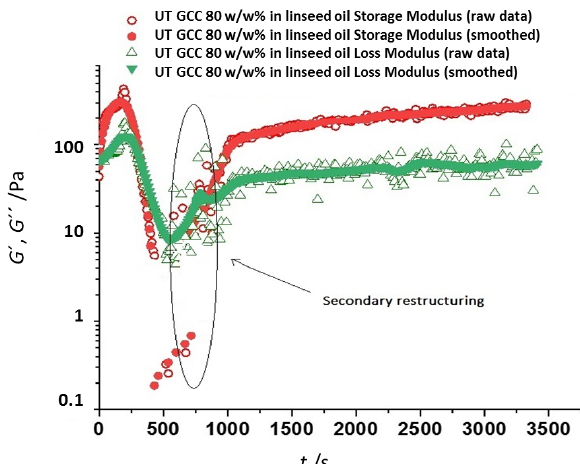
Figure 11: The transitory decoupling at the start of stress relaxation for linseed oil surface treated (varnished) calcium carbonate. The formation of a secondary agglomeration is revealed as a thinning of the boundary-coupled state followed by the disappearance of the decoupled